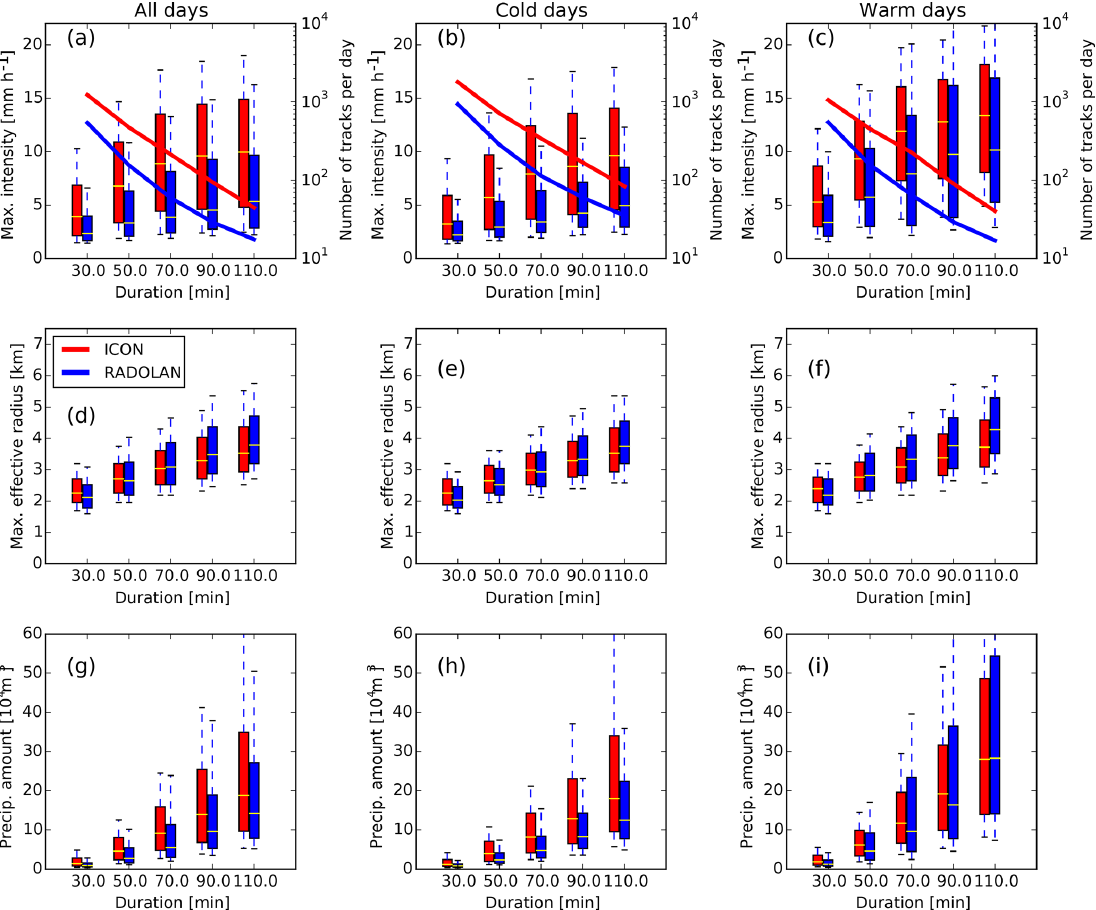
Figure 10. Box-and-whisker plots showing the statistics of solitary tracks for the whole 36d period, for all (a, d, g) , cool (b, e, h) , and warm (c, f, l) days. Values of track maximum intensity (a–c) and track maximum effective radius (d–f) and total amount of precipitation produced by the individual tracks (g–l) are conditioned on track duration ranging between 20 and 120min, in five bins of 20min width. Boxes indicate the 25th and 75th percentiles and the median (red bar); whiskers indicate the 10th and 90th percentiles. The number of tracks in each bin is indicated by the solid lines in panels (a) – (d) (note the logarithmic axis on the